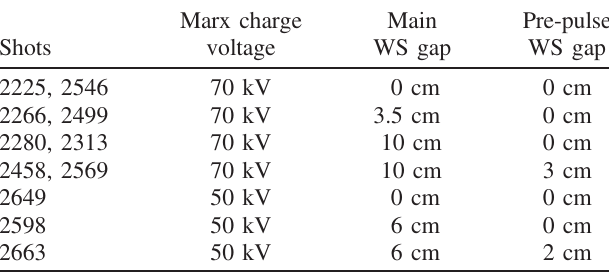
TABLE I. Machine configurations of the short-circuit shots used to refine the resistance and inductance of the laser-triggered gas switch and self-breaking water switch models. A switch gap of 0 cm represents an electrode gap that is electrically shorted.